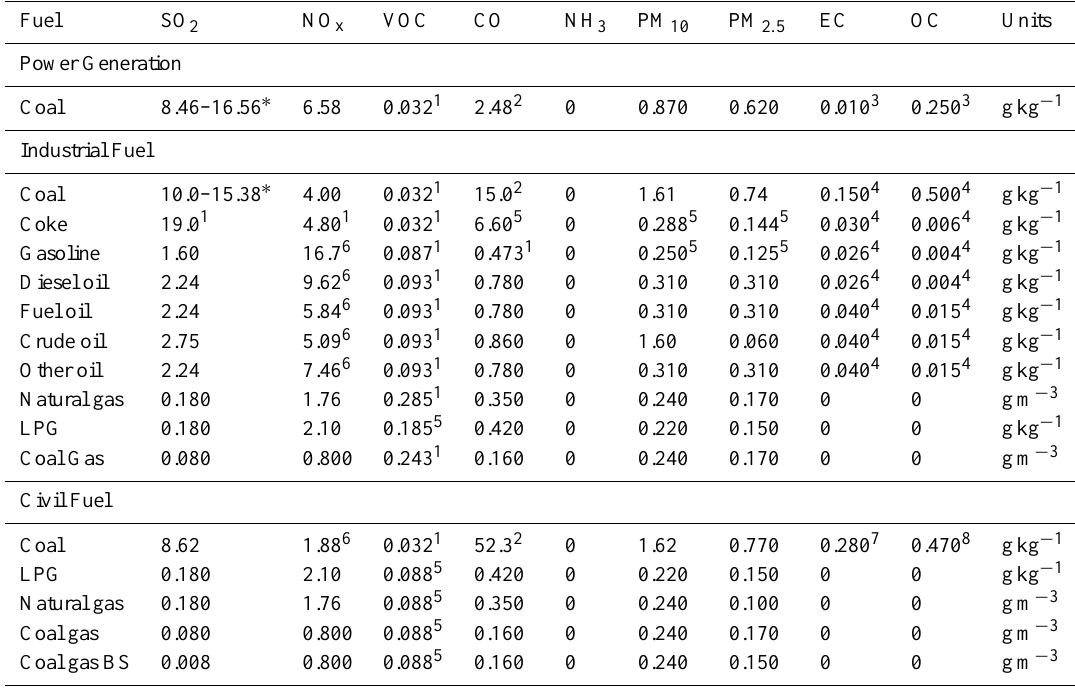
Table 6. Emission factors for power generation, industrial and civil fuel